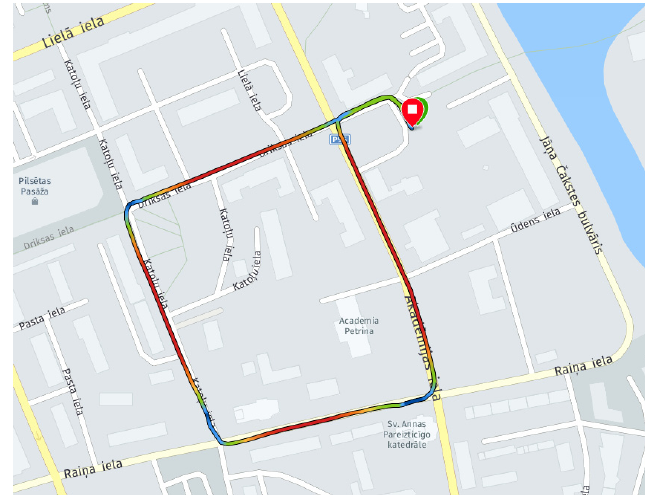
Figure 1. Road test route in Jelgava city.